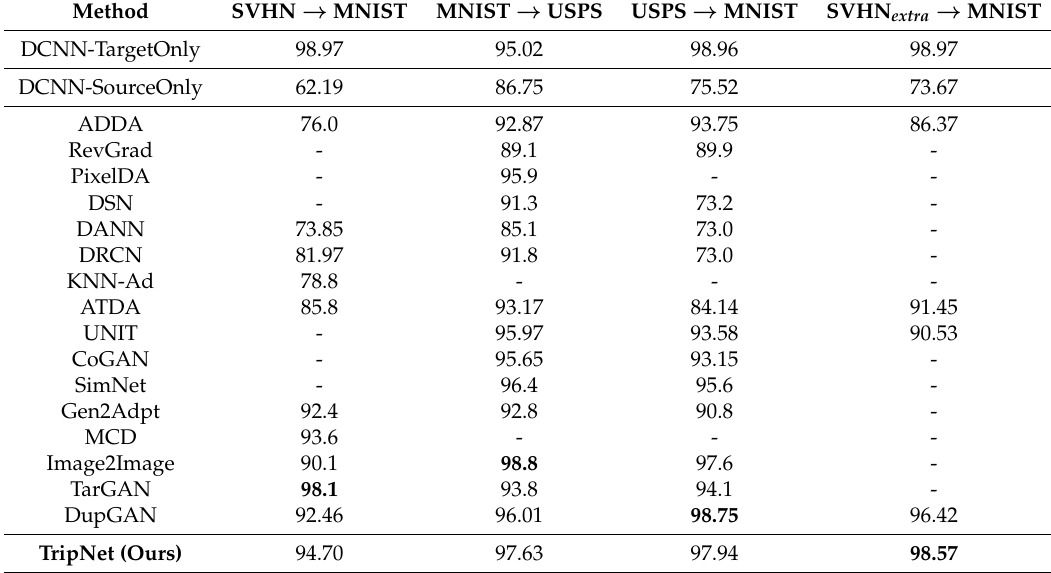
Table 1. Test accuracy comparison for Unsupervised Domain Adapatation on digit